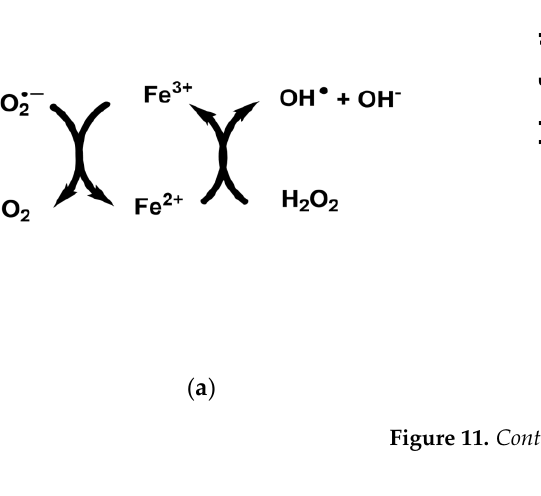
Figure 10. ( a ) Relative HO • concentration in MCF-7 cells loaded with Fe 3 O 4 NPs, AuNC or Fe 3 O 4 @Au pNPs which were exposed to X-radiation at 1 Gy or left non-irradiated; ( b ) relative ROS, O 2 • - and HO • concentration in MCF-7, A549 and MCF-10A cells loaded with Fe 3 O 4 @Au pNPs, which were exposed to X-radiation at 1 Gy (n = 6, *p < 0.05, ***p < 0.001, ****p < 0.0001).